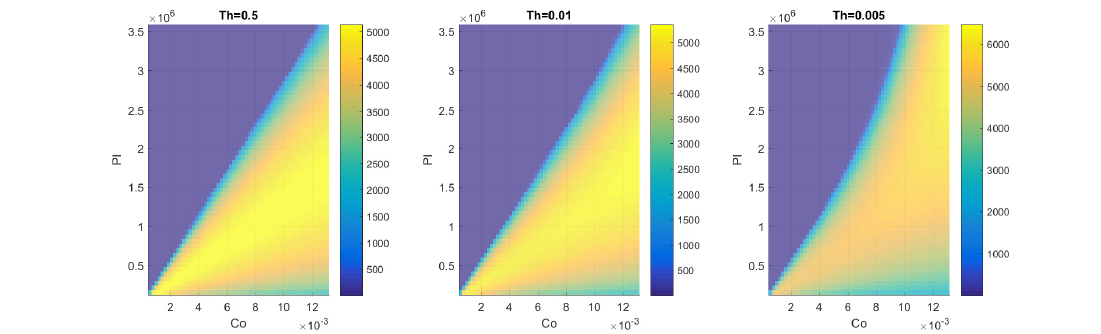
Figure 12. Average value of pressure rise oscillations as a function of Co and Pl for different values of Th for TOA = 4.24.